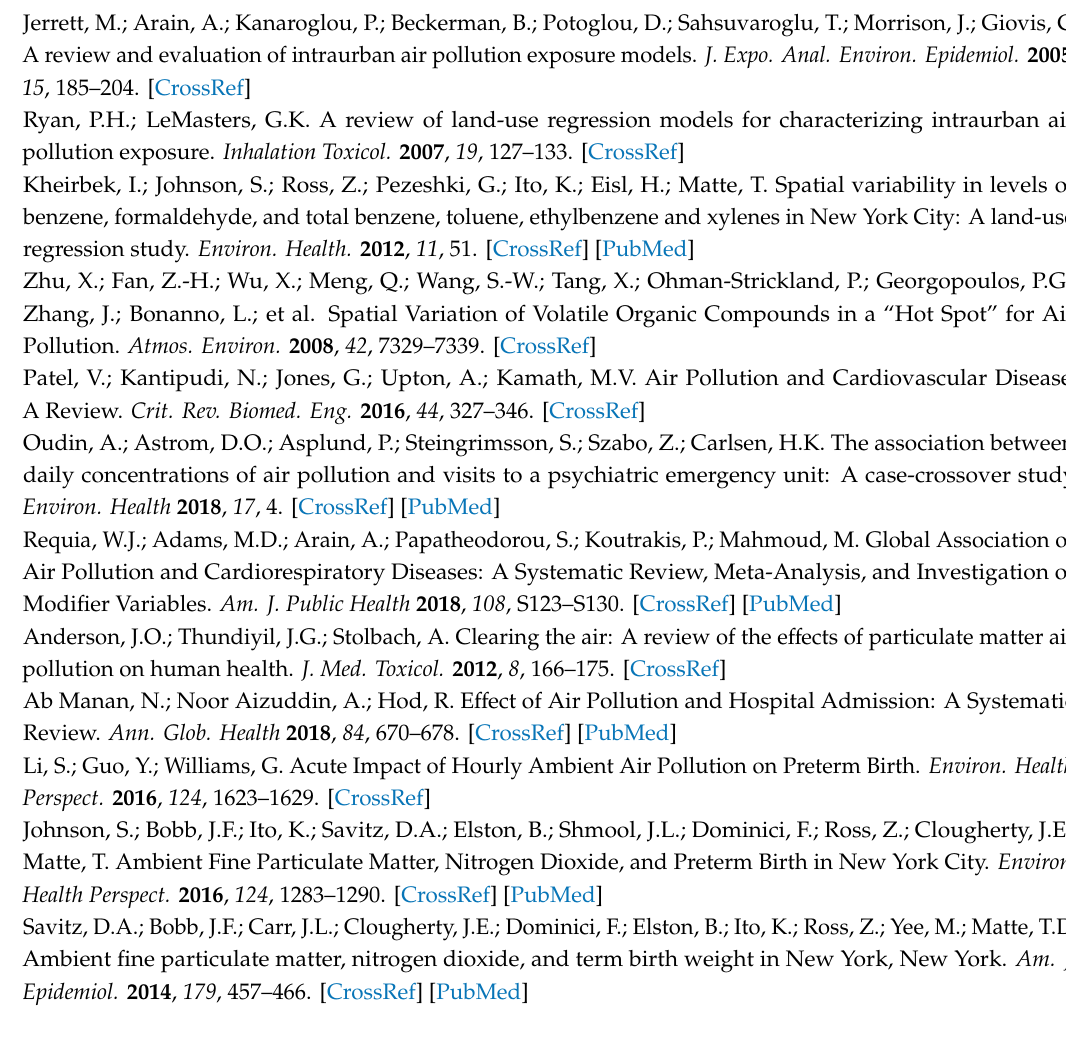
Figure S1: 50 × 50 m grid used for site classification in GIS, Figure S2: Source classification map used for site selection. Numerical class categories refer to (in order): Total tra ffi c density, truck density, distance to port (1 = low, 2 = high, in all cases), Figure S3: Summary of data from Albert St and Albert Park sites, monitored during all four sessions, Figure S4: Scatterplots of temporally-adjusted PM 2.5 concentrations versus source classes, Figure S5: Boxplots of PM 2.5 and BC concentrations by source category (Total tra ffi c density, truck density, distance to port). In all cases, we found non-normal distributions in concentrations, and slightly higher average concentrations in the high-source category, Figure S6: PM 2.5 concentration versus windspeed, across sessions, at two reference sites (Albert St is a low-elevation street canyon in the center of CBD; Albert Park is a high-elevation green park adjacent to the